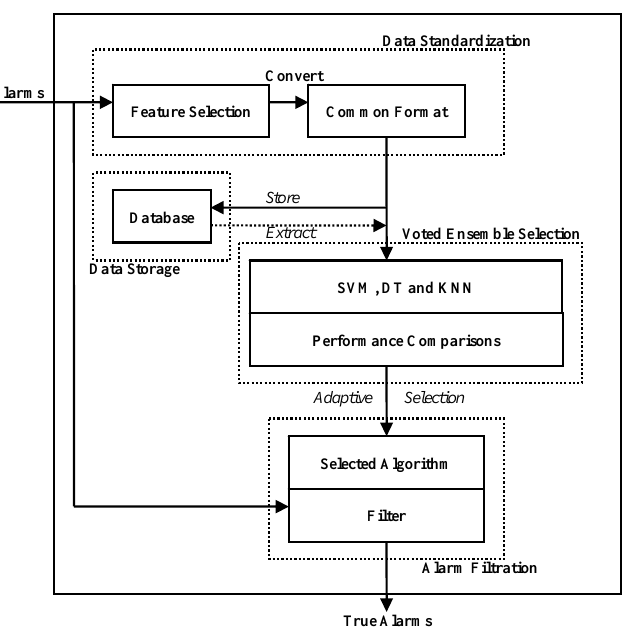
Fig. 1. The architecture of our proposed intelligent false alarm